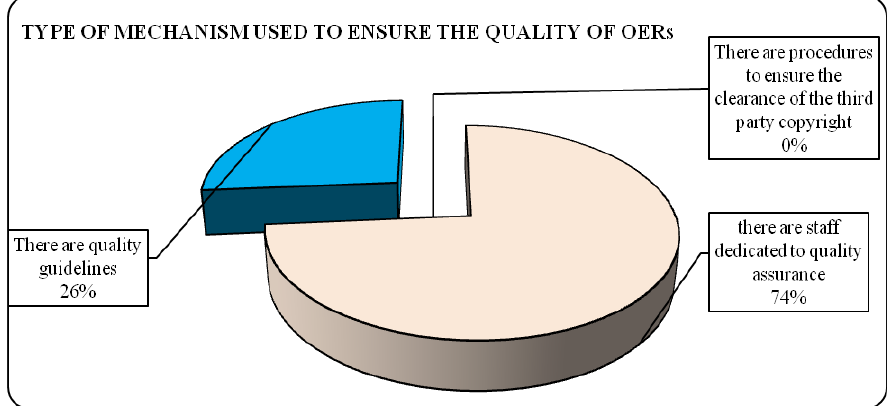
Figure 5 . Mechanisms to ensure quality of OER Source.